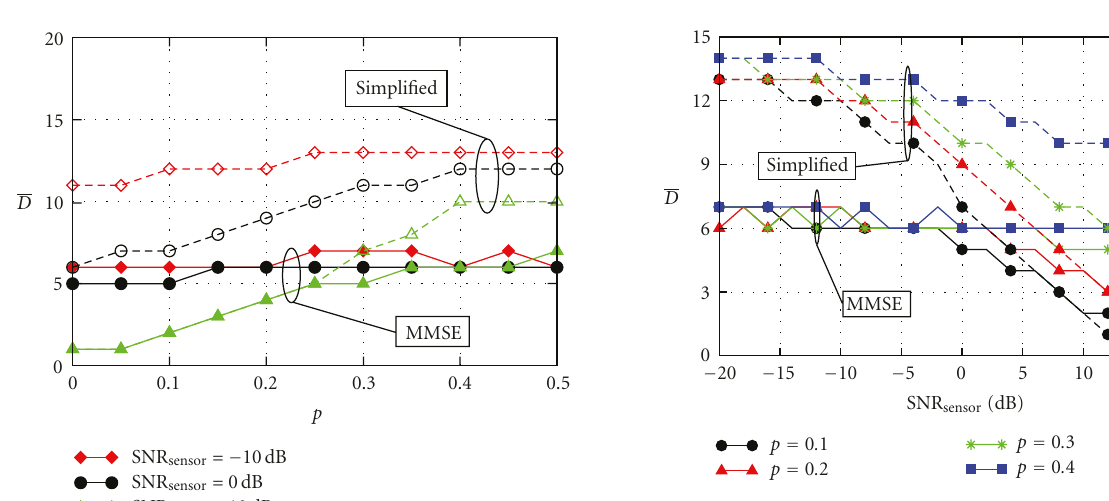
Figure 4: Distance, as a function of the sensor SNR, in a scenario with N = 8 sensors and binary quantization. Four di ff erent values of the cross-over probability p are considered: (i) 0.1, (ii) 0.2, (iii) 0.3, and (iv) 0.4. Both MMSE and simplified detection algorithms at the AP are